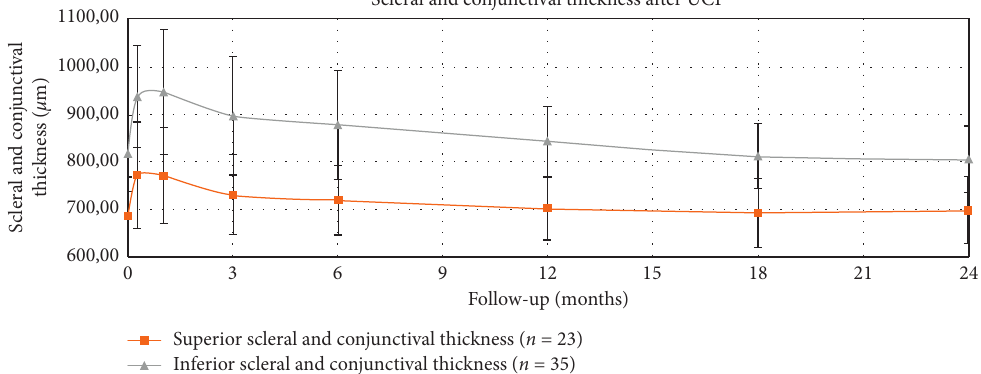
Figure 6: Scleral and conjunctival thickness in superior and inferior scleral mark after UCP—24-month